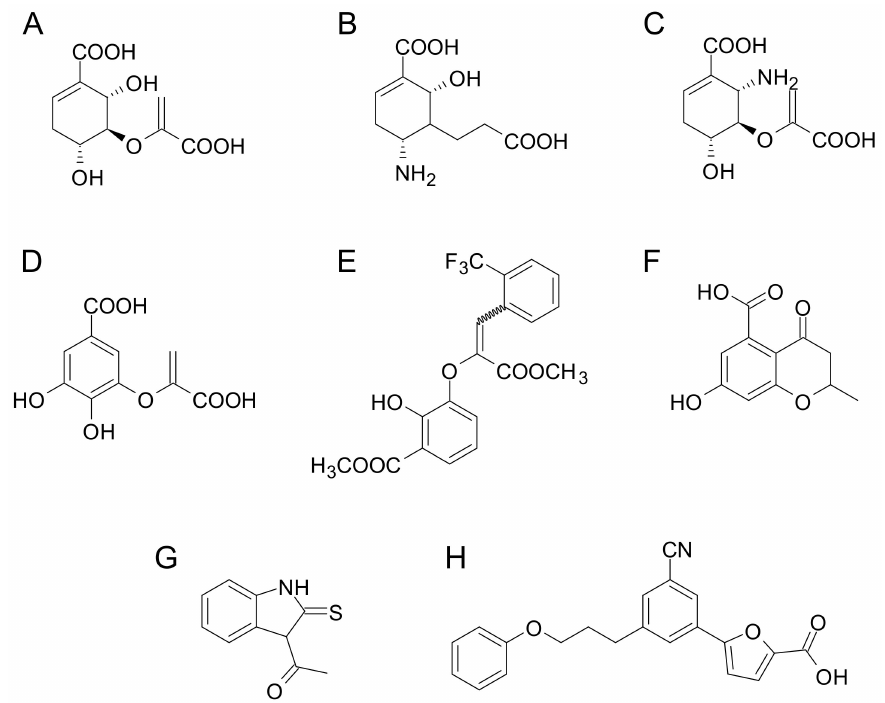
Figure 6. Chemical structures of the most active inhibitors of MbtI: transition-state analogs ( A – F ) and non-transition-state derivatives, namely benzimidazole-2-thione ( G ) and phenylfuran carboxylate ( H )